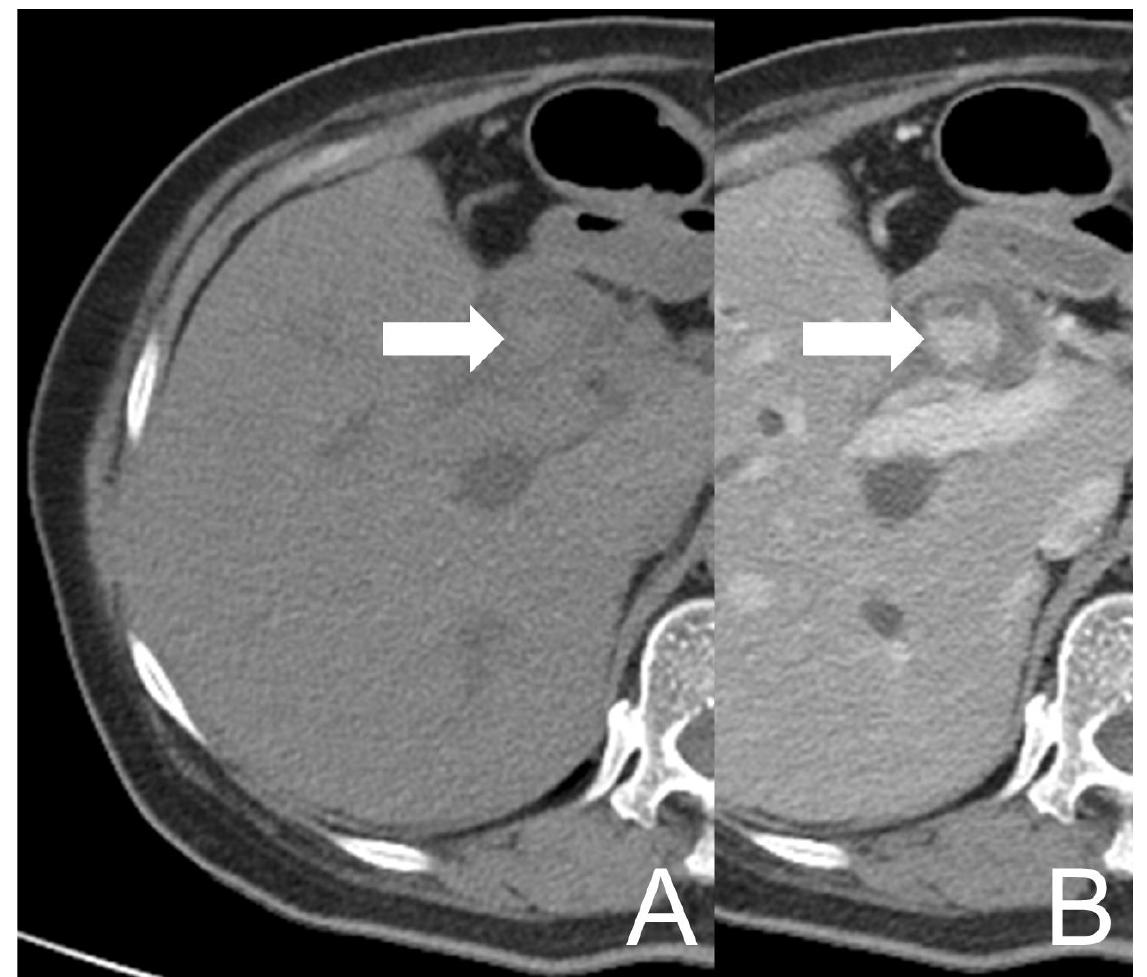
Figure 2. UCOGC of CHD and CBD in a 66-year-old female, 4 months after the initial presentation. The axial CT images show a mass (arrow) in CBD, demonstrating relatively high density on the pre-contrast image ( A ) and heterogeneous enhancement on the post-contrast image ( B ). The imaging findings are compatible with a neogrowth with hemorrhage.